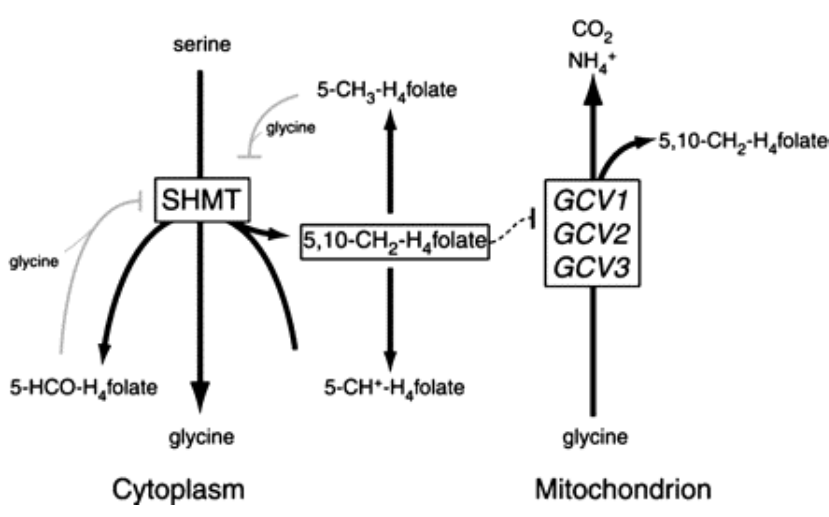
FIGURE 3. Model of how cells regulate one-carbon metabolism and gene transcription via the activity of cytoplasmic SHMT. Regulation of SHMT activity by a side reaction dictates cytoplasmic 5,10-CH2-H4folate levels, which mediate transcription of genes involved in generation of one-carbon units from glycine. This control loop has the effect of shifting the balance of one-carbon metabolism toward the mitochondrial reactions. Solid black arrows indicate enzyme-catalyzed reactions; gray lines indicate control of enzyme activity; and the dashed line indicates regulation of gene expression[11]. Permission